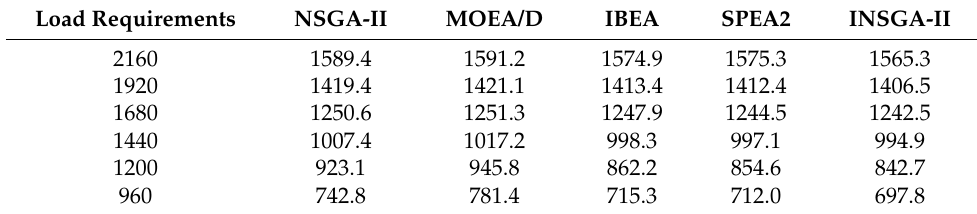
Table 7. Comparison of the optimization results of different algorithms in Case 1.